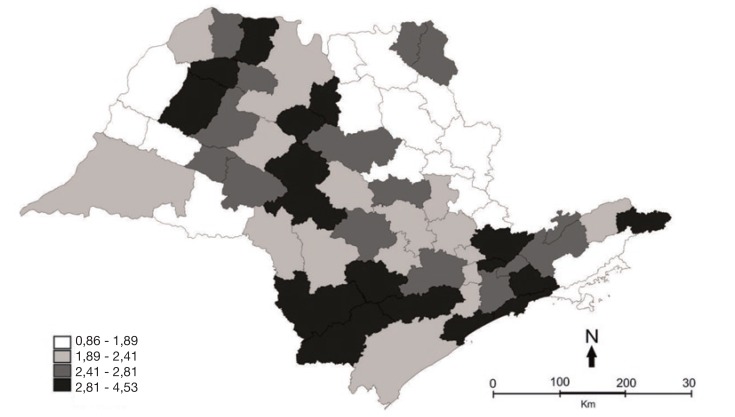
Mapa temático da distribuição das taxas de mortalidade neonatal tardia,
por 1000 nascidos vivos, segundo microrregiões, São Paulo, 2006-2010